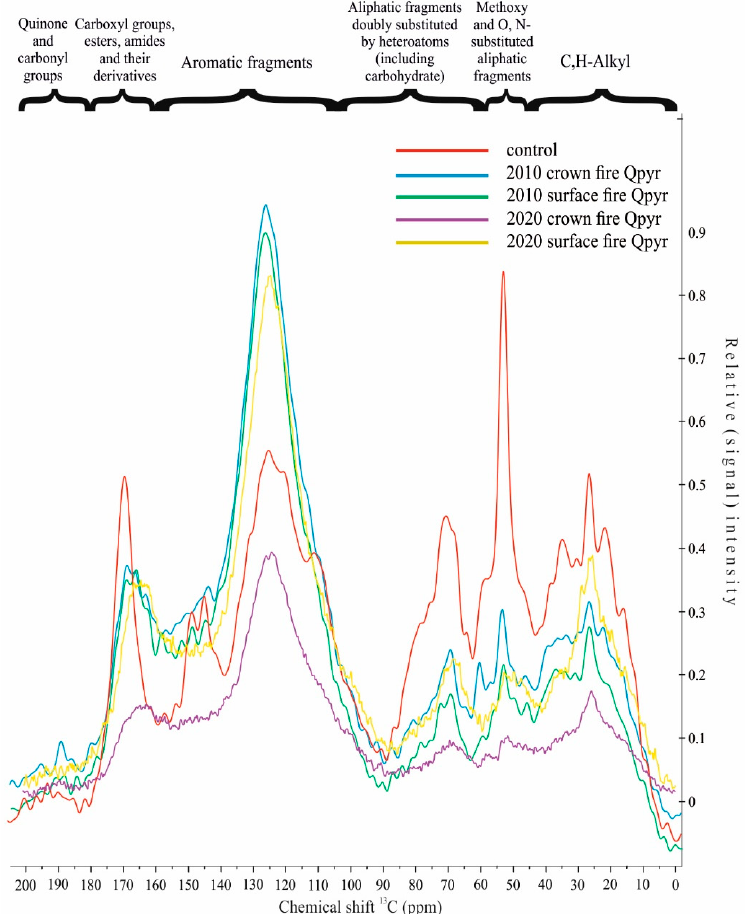
Figure 3. The 13 C NMR spectra of HAs isolated from studied soils.